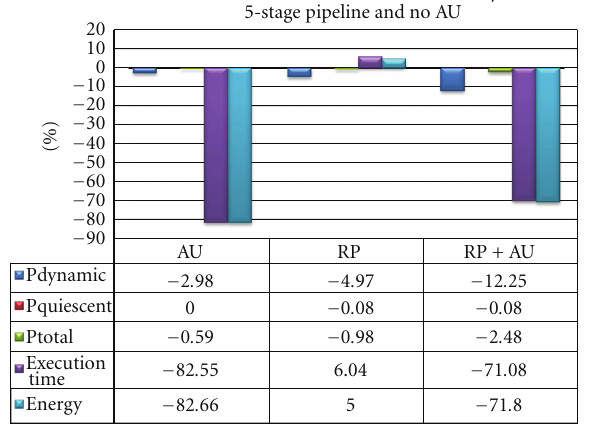
Figure 28: Impact of the MicroBlaze configurations for the NCC algorithm.